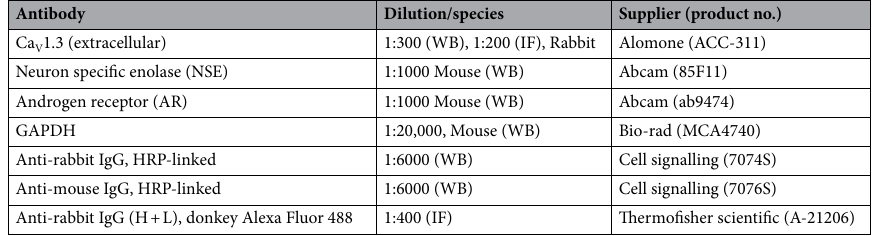
Table 2. Western blotting and IF